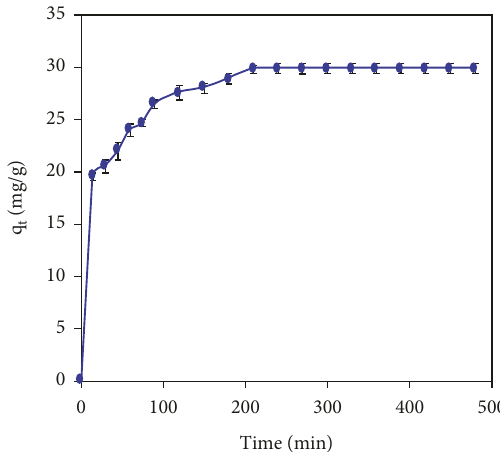
Figure 7: The influence of the agitation time for Cr(VI) bio- sorption on CADSP.